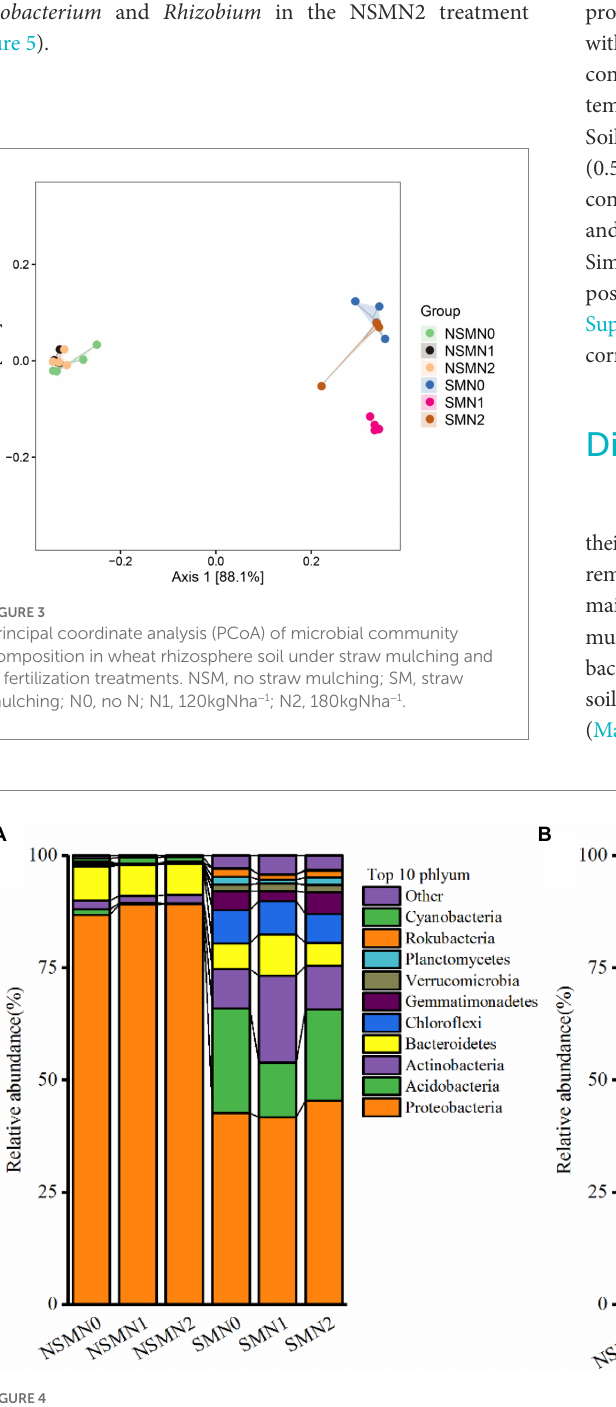
FIGURE 4 Bacterial community composition in wheat rhizosphere soil under straw mulching and N fertilization treatments. (A) , phylum level; (B) , genus level. NSM, no straw mulching; SM, straw mulching; N0, no N; N1, 120 kg N ha − 1 ; N2, 180 kg N ha − 1 .